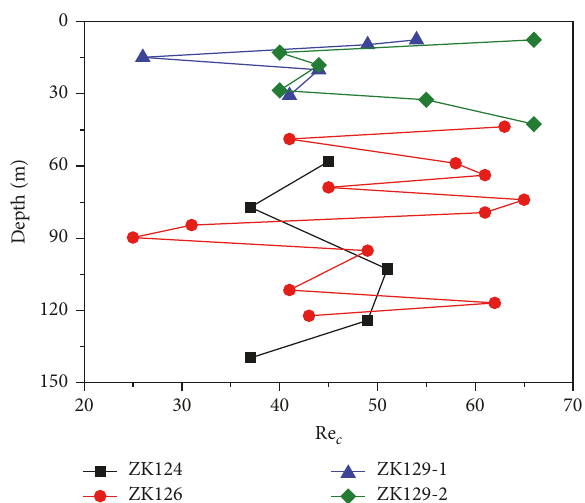
Figure 13: Relationships between Re 𝑐 and 𝜎 𝑛 based on the data replotted from Rong et al. ([100], Figure 9